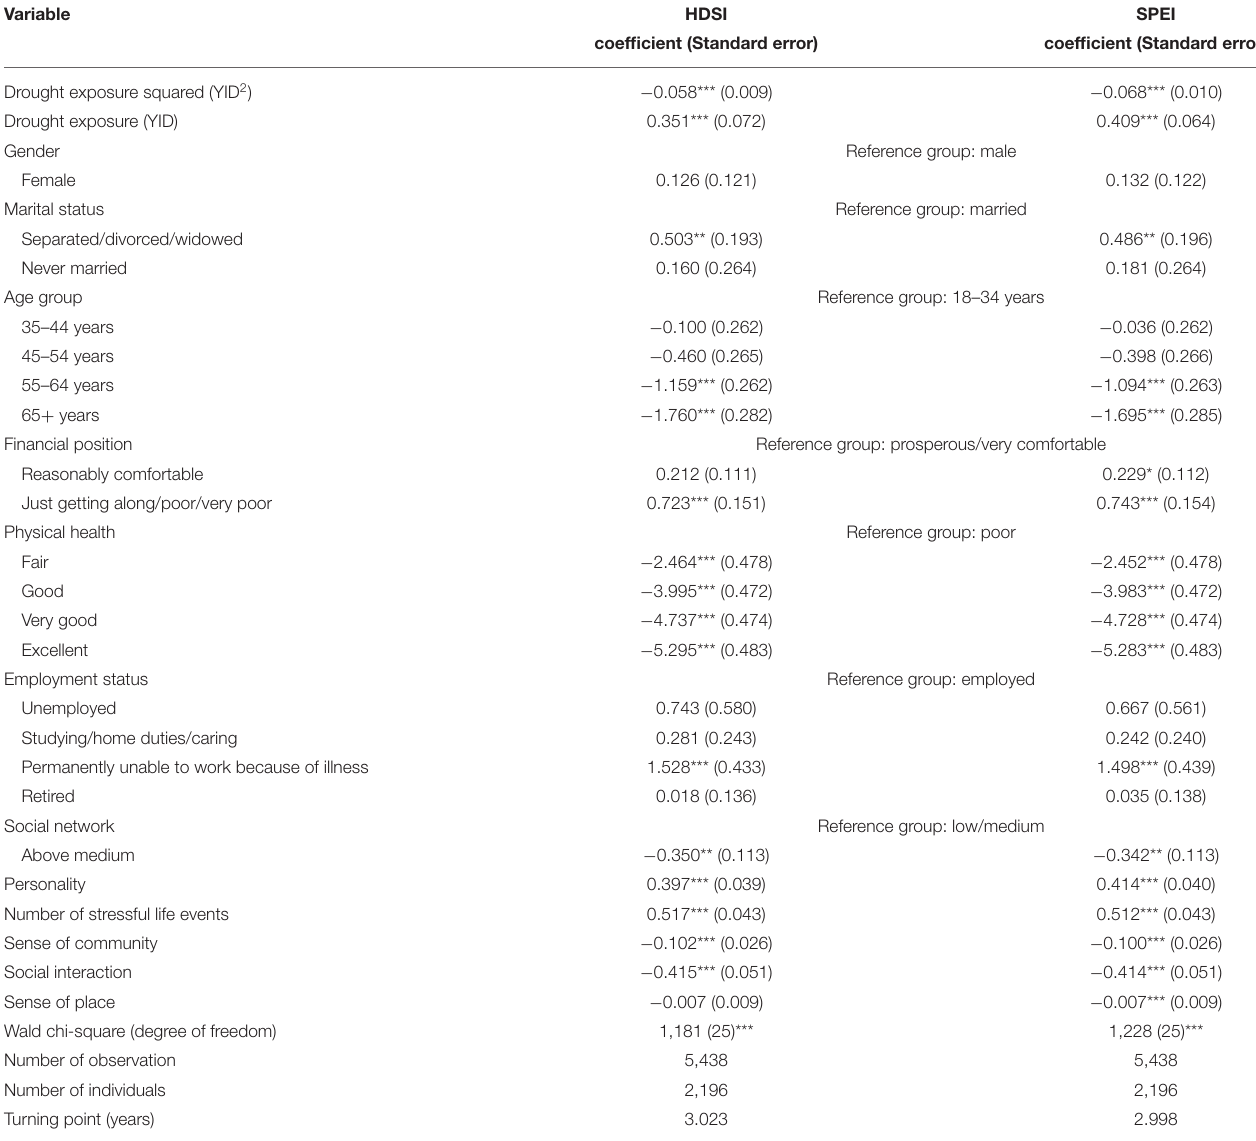
TABLE 2 | Regression results testing the non-linear relationship between drought and mental health.